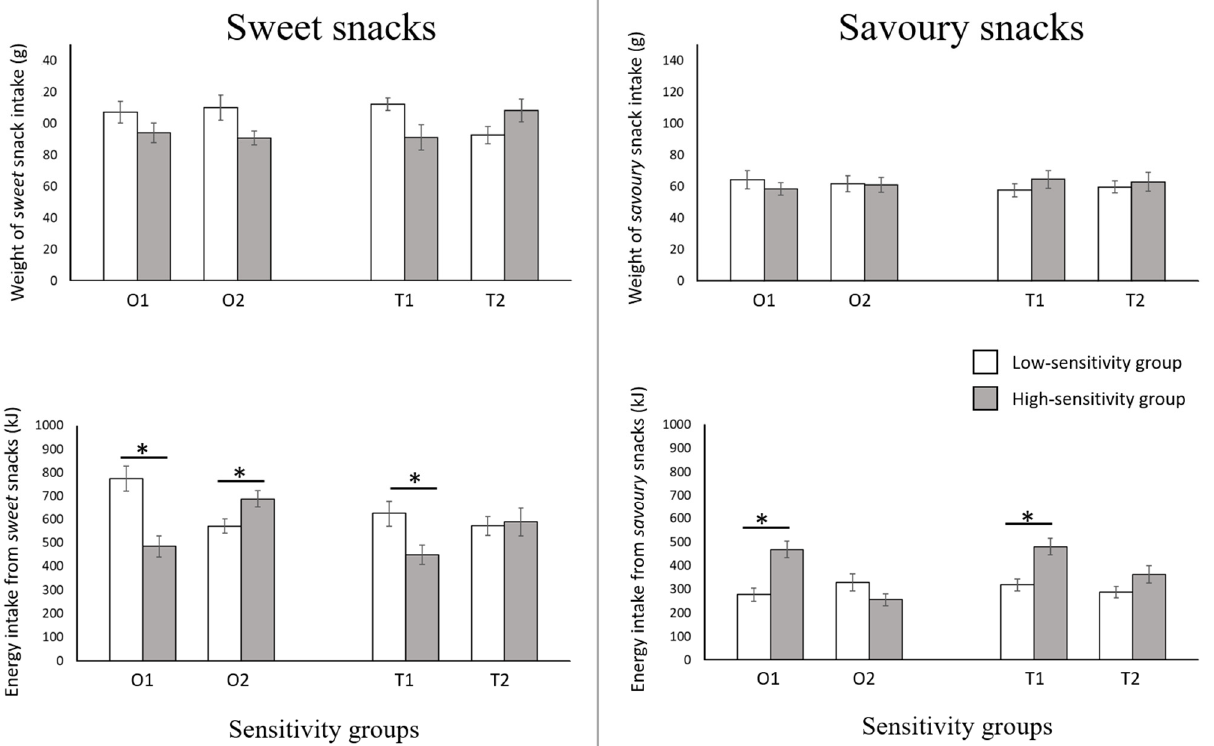
Figure 1. Bar graphs illustrating the weight and energy intake of sweet and savoury snack categories between “high” and “low” sensitivity groups, for two-olfactory (O1—vanillin, O2—methional) and two-gustatory stimuli (T1—sucrose, T2—NaCl). The error bars demonstrate the standard error for sweet and savoury snack intake measures. Significant differences ( p < 0.05) in snack intake between the “high” and “low” sensitivity groups are indicated by an asterisk.